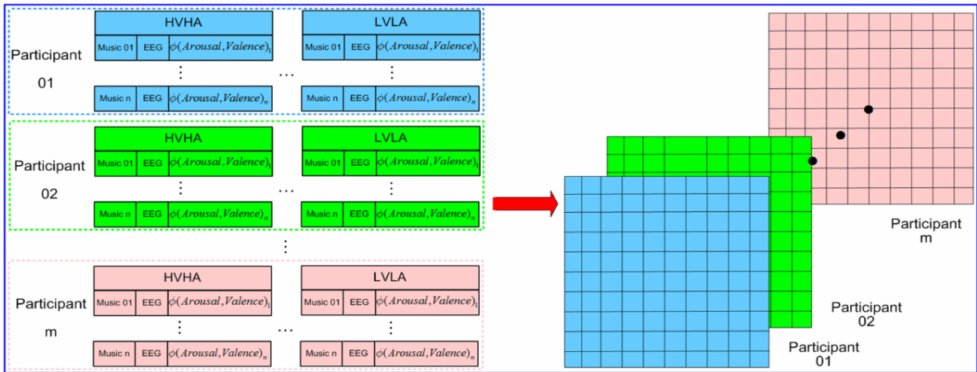
Figure 6. Personalized reconfigurable music-EEG